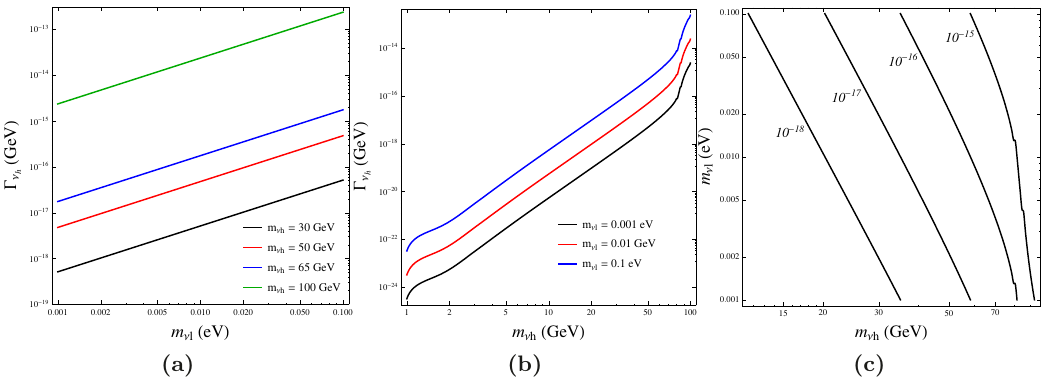
Figure 4. Total decay width of the heavy neutrino at rest as a function of (a) the light neutrino mass, m ν , and of (b) the heavy neutrino mass, m ν l width at rest (in GeV) in the plane ( m ν